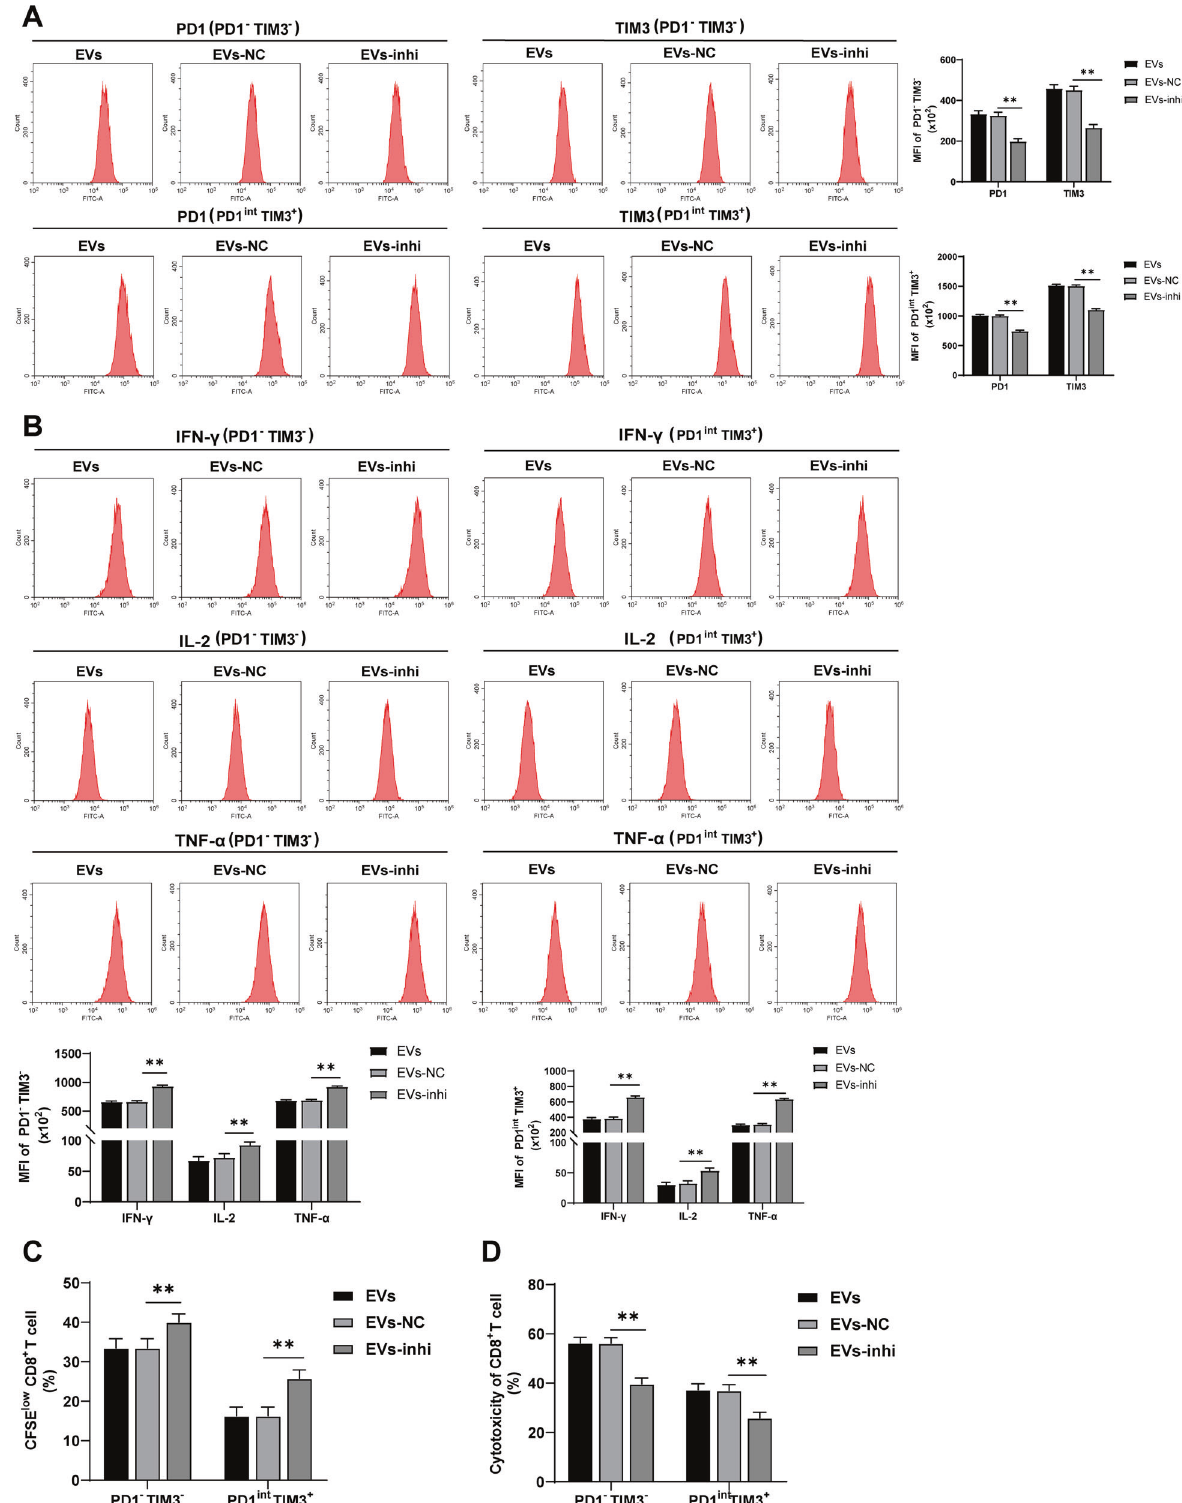
Fig. 4 Inhibition of miR-21-5p in EVs partially reversed the promoting effect of EVs on CD8 + T cell exhaustion. M2 macrophages were transfected with miR-21-5p inhibitor and then EVs were isolated. The isolated EVs were co-cultured with PD1 - TIM3 - and PD1 int TIM3 + cells. A The expressions of PD1 and TIM3 were detected using fl ow cytometry. B The expressions of IFN- γ , IL-2, and TNF- α were detected using fl ow cytometry. C The proliferation ability of CD8 + cells was measured using fl ow cytometry. D The ability of CD8 + cells to kill Hep1-6 cells was measured using fl ow cytometry. The cell experiment was repeated 3 times. Data are presented as mean ± standard deviation and analyzed using one-way ANOVA, followed by Tukey ’ s multiple comparison test, ** p < 0.01.